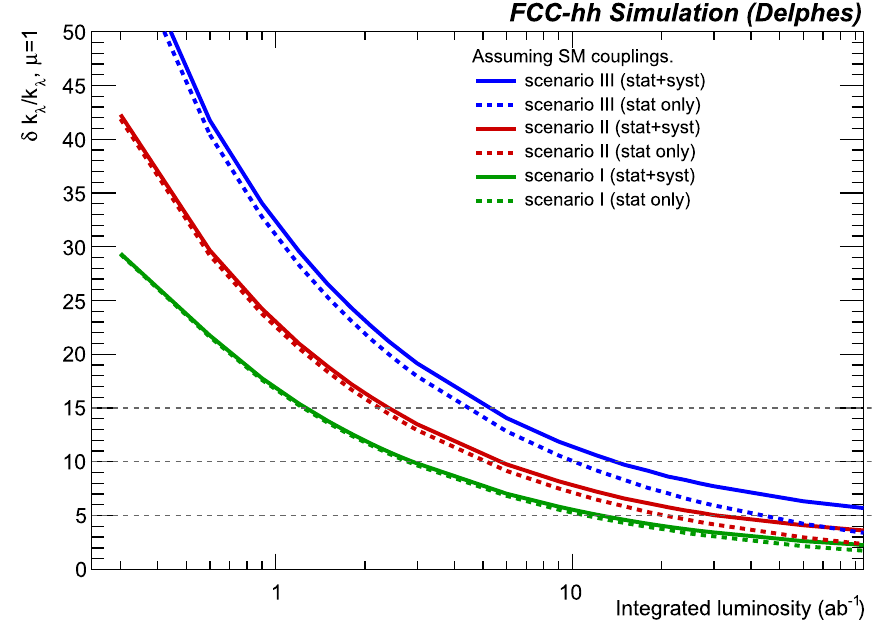
Fig. 14 Expected precision on the Higgs self-coupling as a function of the integrated luminosity